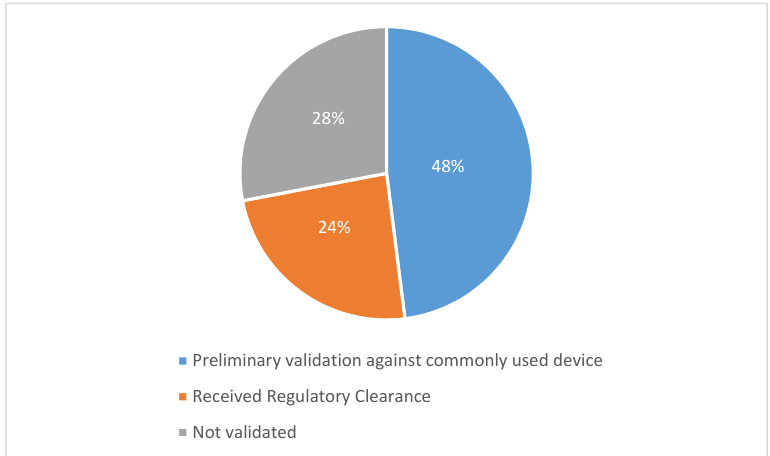
Figure 2. The chart shows the proportion of reviewed commercial devices (in Section 4.2) and their type of validation, if